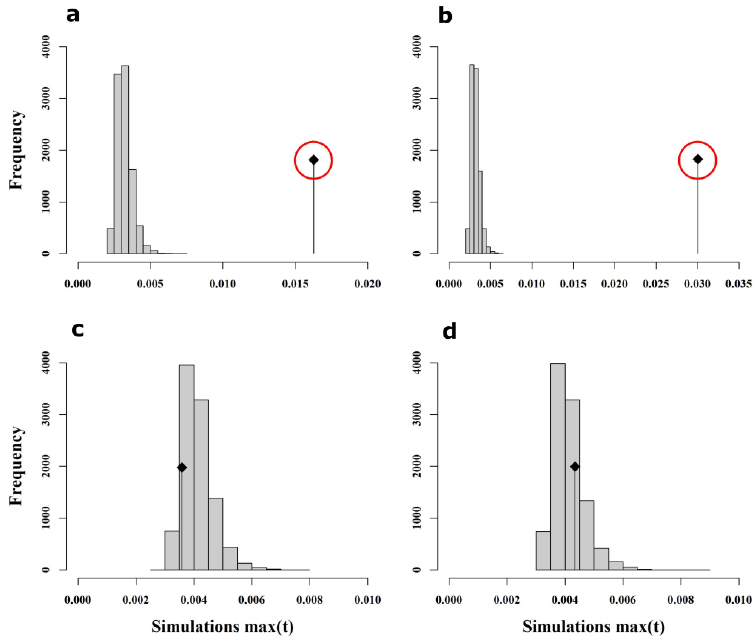
Figure 5. Results of Monte Carlo simulations using wing shape data. The x-axis represents max(t) calculated in each permutation whereas the y-axis represents the frequency of each max(t) class. The observed max(t) value is represented by the vertical black line with the black square on top. Monte Carlo simulations support the existence of global structure for both sexes (a-drones; b-workers) but not local structure (c-drones; d-workers), as indicated by the location of the observed max(t) value outside ( a , b ) or inside ( c , d ) the histogram of simulated values. Outside locations of observed max(t) values specify statistical significance (indicated by the red circle).